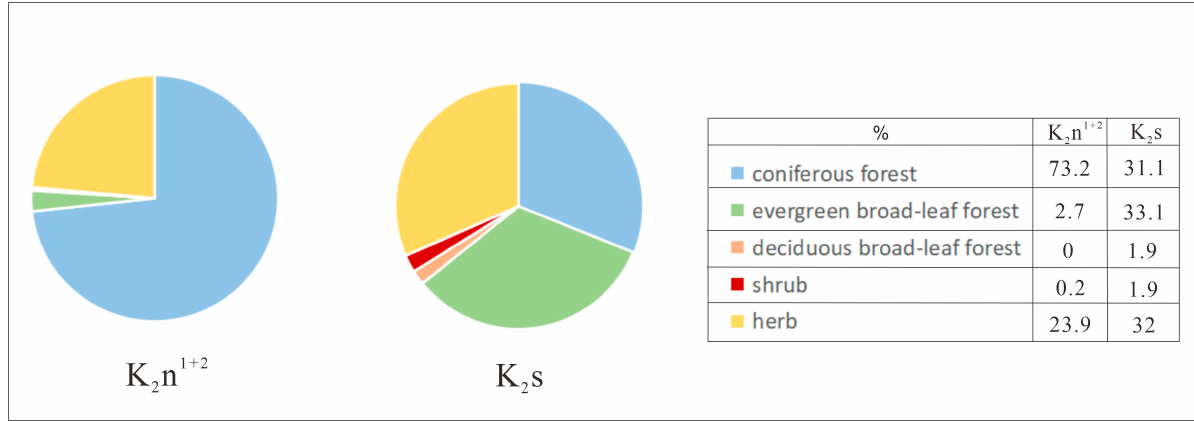
Figure 7. Ratio of different vegetation types represented by palynomorphs in borehole ZKY2-1. Table 2. Vegetation-types table. References: (1): [17]. Vegetation Types